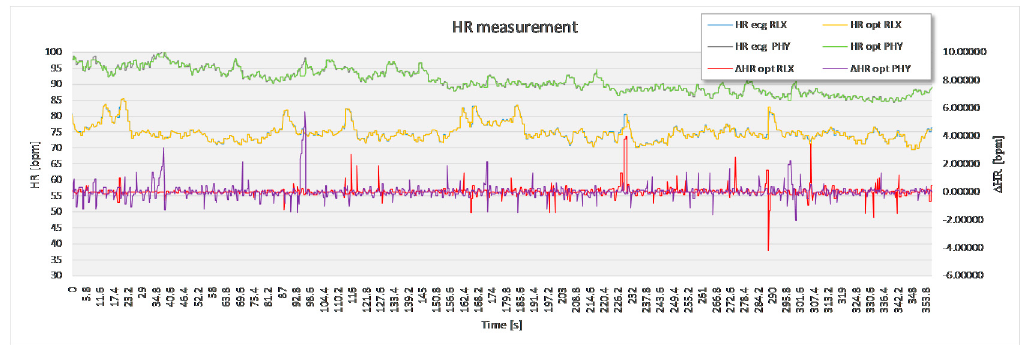
Figure 11. Recorded signal in laboratory experiment for subject 4.